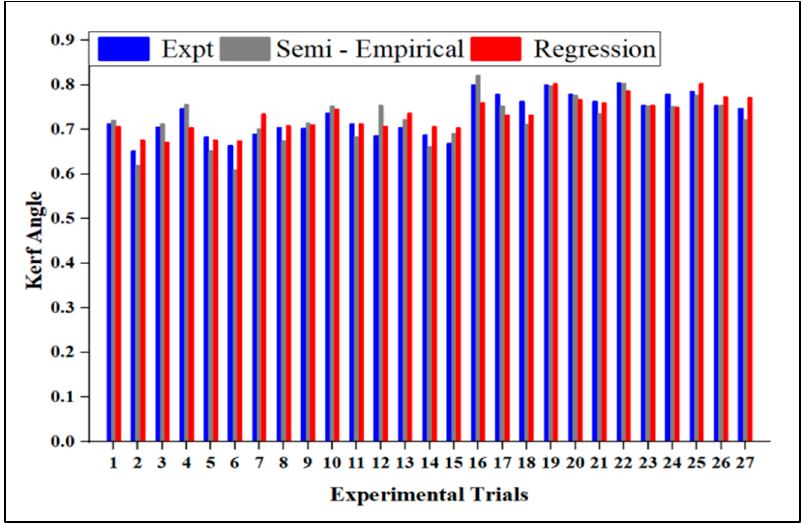
Figure 11. A comparison of Ka between the experimental, semi-empirical, and regression methods.